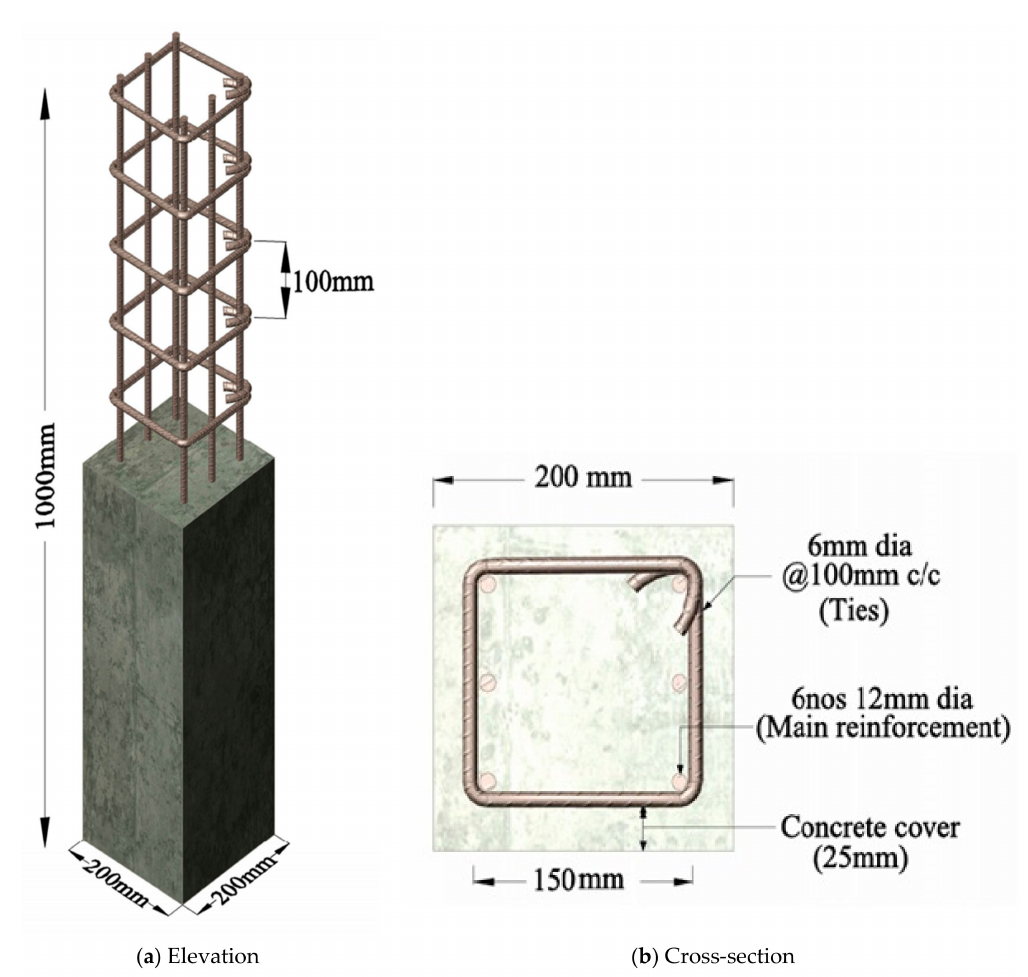
Figure 1. The size and reinforcement detail of the test